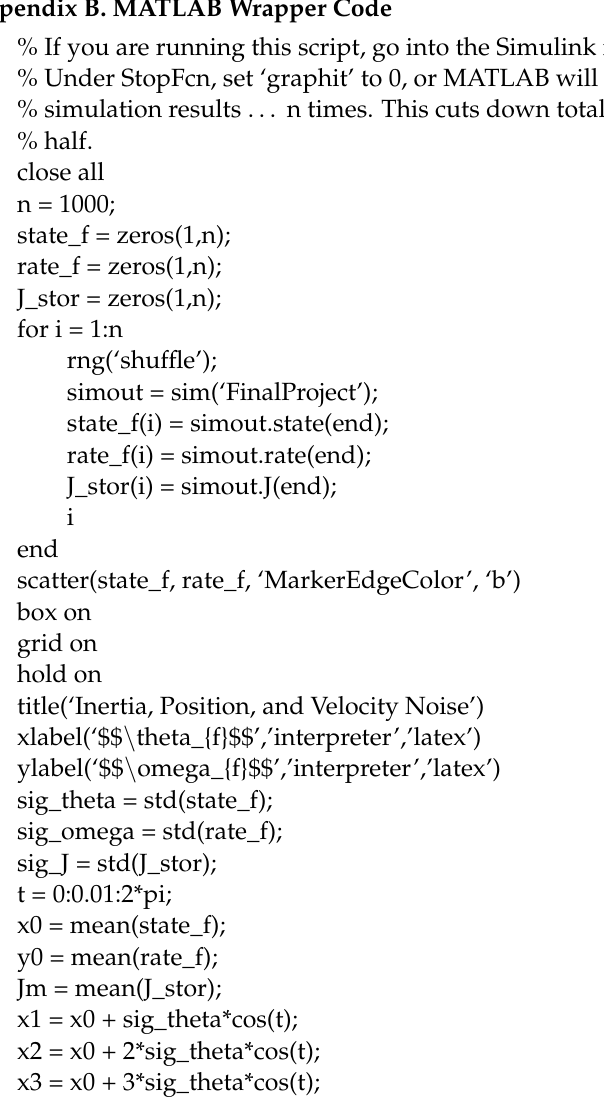
Figure A8. Noisy sensor-fusion simulation topology.